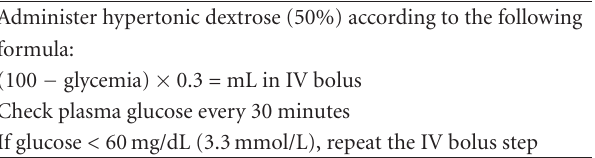
Table 3: Reactive regimen (according to monitorized values). The measurement unit used for indicating the concentration of blood or plasma glucose can either have a weight dimension (mg/dL) or a molarity (mmol/L).